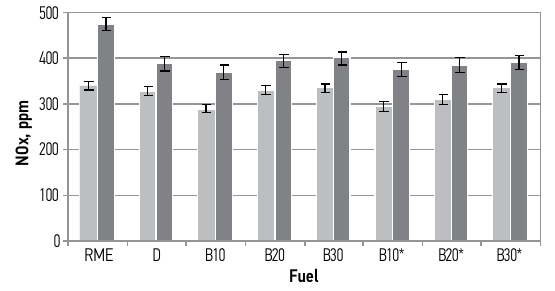
Fig. 1 . The dependence of NO x emissions on fuel composition at the engine rotation speed of: